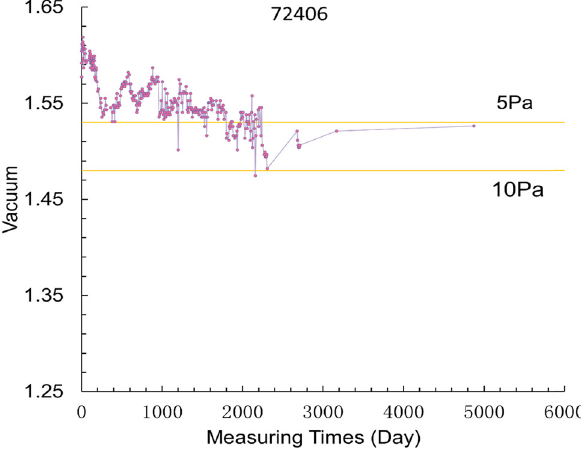
Figure A3: Relationship between vacuum holding voltage and time in No. 72416 vacuum packaging shell.